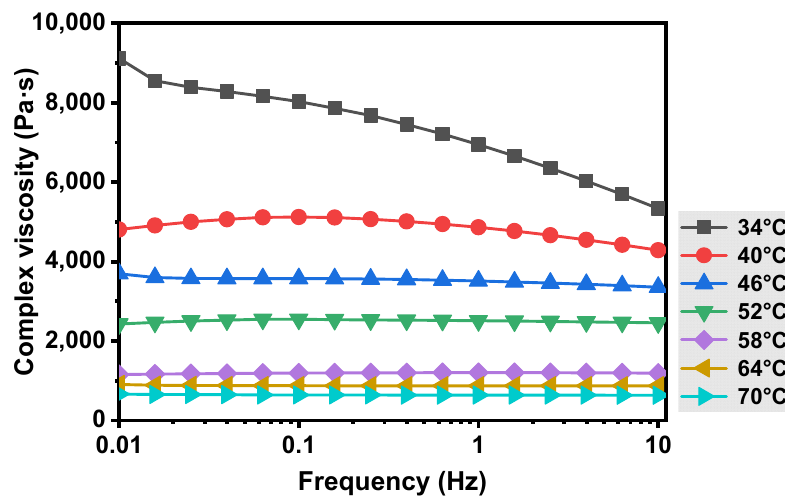
Figure 4. Frequency-complex viscosity relationship of the basic bitumen under different temperatures. Table 5. Fitted results of flow behavior index at different temperatures.